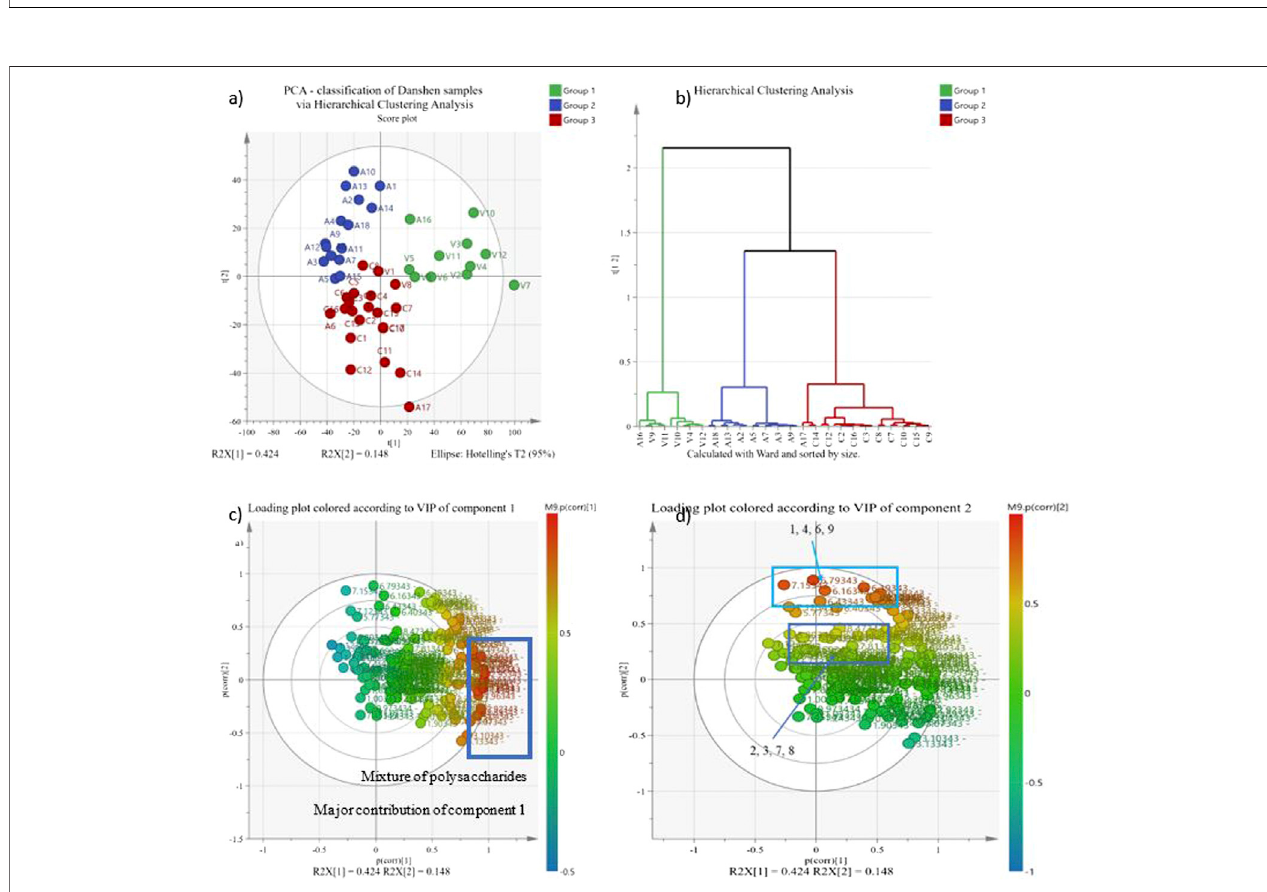
FIGURE 3 | PCA of all Danshen samples. The PCA-X corresponds to the binned regions of all 1 H-NMR spectra of Danshen samples as X variables. All X variables are scaled by Pareto scaling. In (A) PCA scatter score plot and (B) Hierarchical Clustering Analysis for PCA, Figure (C) and (D) are the loading plots of fi gure (A) . The colours of the loading plots are referring the p value of the X variable contribute to the principal component 1 in fi gure (C) , and the component 2 in fi gure (D) . A, authenticated samples; C, Chinese online store samples; V, Vietnamese samples